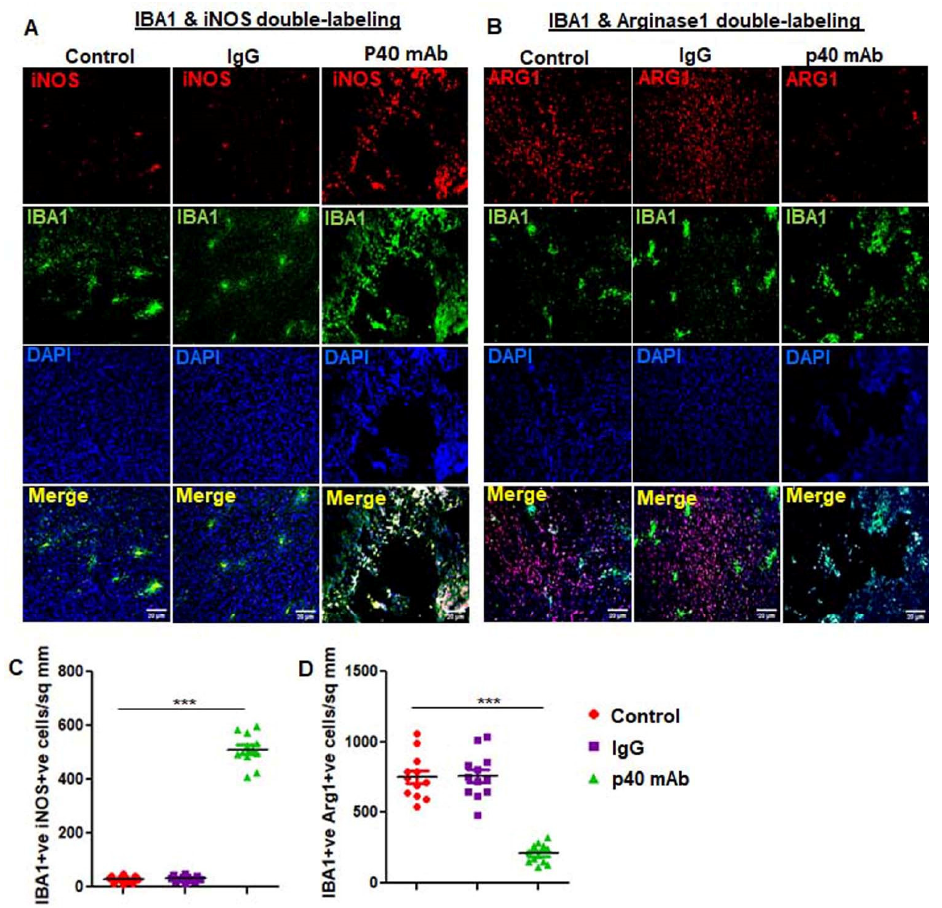
Figure 8. Neutralization of p40 by p40 mAb downregulates tumor-associated M2 (TAM2) macrophages, while upregulating TAM1 macrophages in TNBC tumor of PDX mice. Female 6–8 week old NSG mice were engrafted TNBC tumor in the flank. After about 4 weeks of engraftment, when tumors of PDX mice were 0.6–0.8 cm 2 in size, mice were treated with p40 mAb and hamster IgG at a dose of 2 mg/kg body wt once a week. After 2 weeks of treatment, tumor cross sections were double-immunolabeled for either Iba1 & iNOS ( A ) or Iba1 & Arg1 ( B ). DAPI was used to stain nuclei. Cells positive for Iba1 & iNOS ( C ) and Iba1 & Arg1 ( D ) were counted in one section (2–3 images per section) of each of five different mice per group. *** p < 0.001.